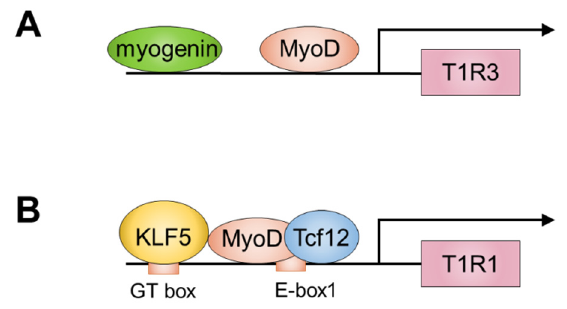
Figure 3. Myogenic regulatory factors regulate the expression levels of T1R1 and T1R3 during my- ogenesis. MyoD and myogenin binding the promoter region of T1R3 ( A ). The heterodimer of